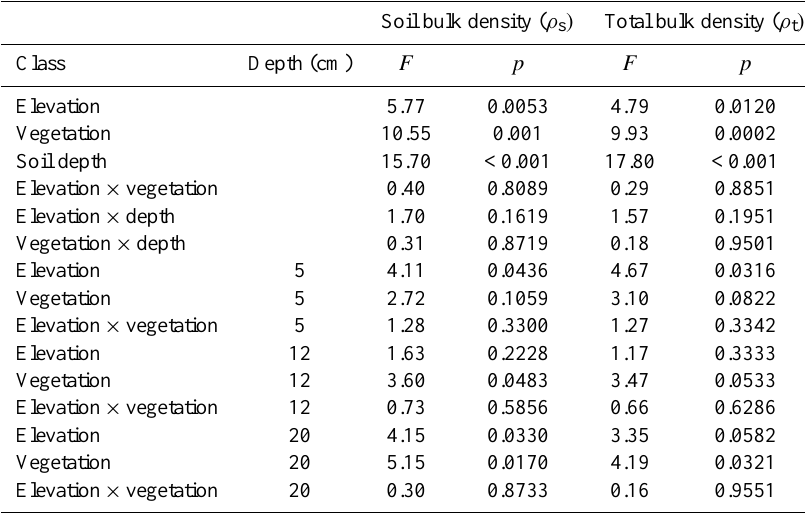
Table B1. Mixed-model ANOVA results for the main and interactive effects of elevation, vegetation, and soil depth on soil bulk density ( ρ s ) and total bulk density ( ρ t )